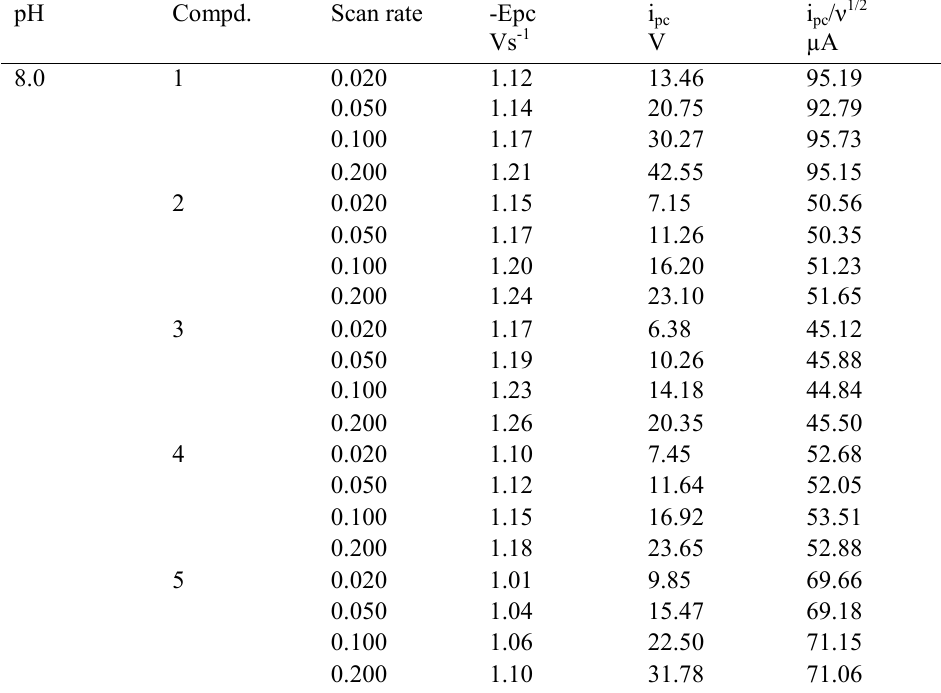
Table 4 . Cyclic voltammetric data of compounds 1-5 at pH 8.0 Conc. = 1 mM, Medium = 65% (V/V) DMF. pH